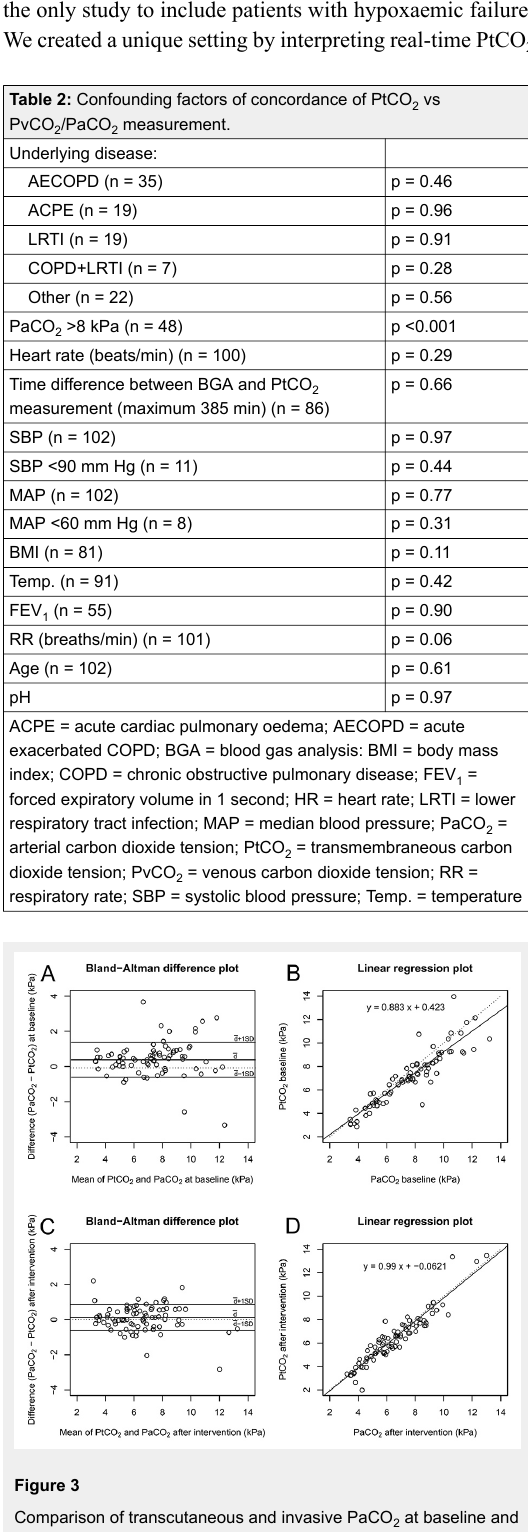
Comparison of transcutaneous and invasive PaCO 2 at baseline and after intervention. Measurements were compared using both a Bland-Altman plot (A, C) and a linear regression plot (B, D). A and B at baseline, C and D after NIV. The Bland-Altman plot displays the mean bias and limits of agreement (solid lines). The linear regression plot displays the line of best fit (solid line) and the identity line (dashed